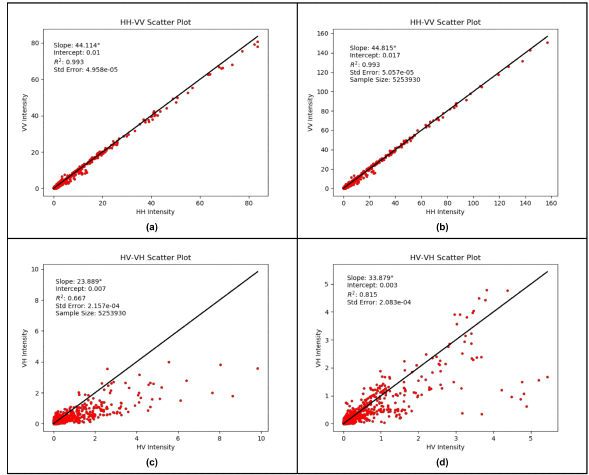
Figure 4. (a) Scatter Plot of HH and VV before calibration, (b) Scatter Plot of HH and VV after calibration, (c) Scatter Plot of HV and VH before calibration, (c) Scatter Plot of HV and VH after calibration crosspol channels are more organised along the y = x line after the